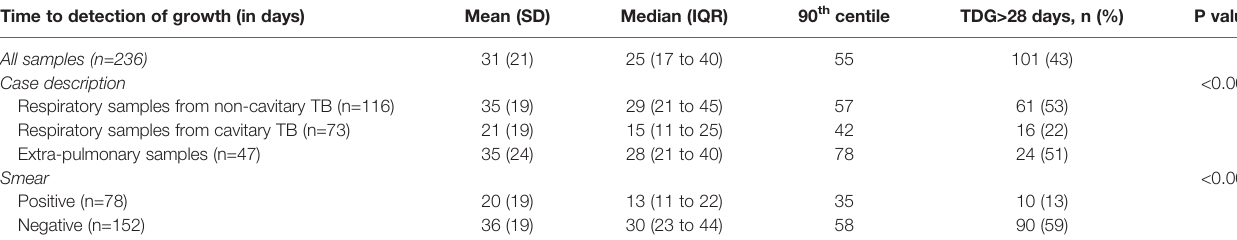
TABLE 4 | Time to detection of growth (TDG) according to results of microscopy and clinical presentation. Time to detection of growth (in days)